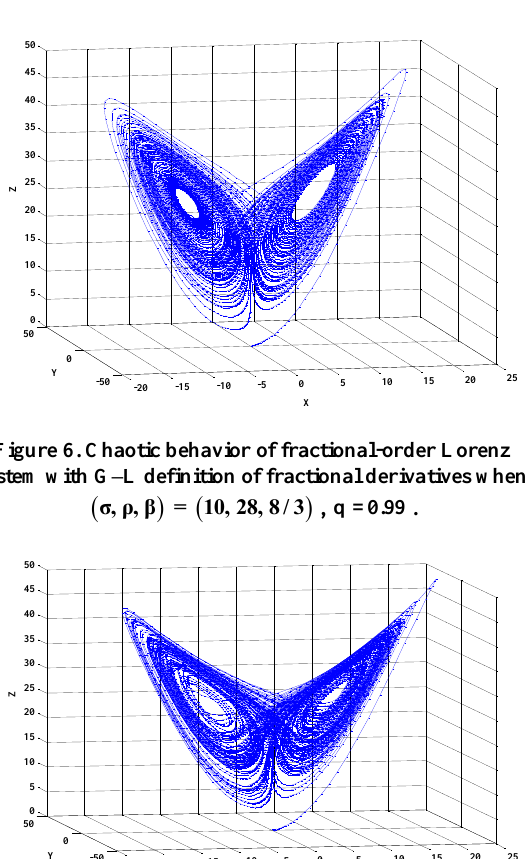
Figure 7. Chaotic behavior of fractional-order Lorenz system with approximated fractional derivatives when   σ, ρ, β = 10, 28, 8/ 3 , q =0.99 , and N = 6